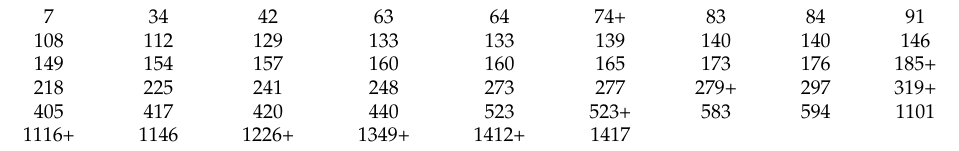
Table 1. Censored survival times from Arm A (Chemotherapy) of the NCOG